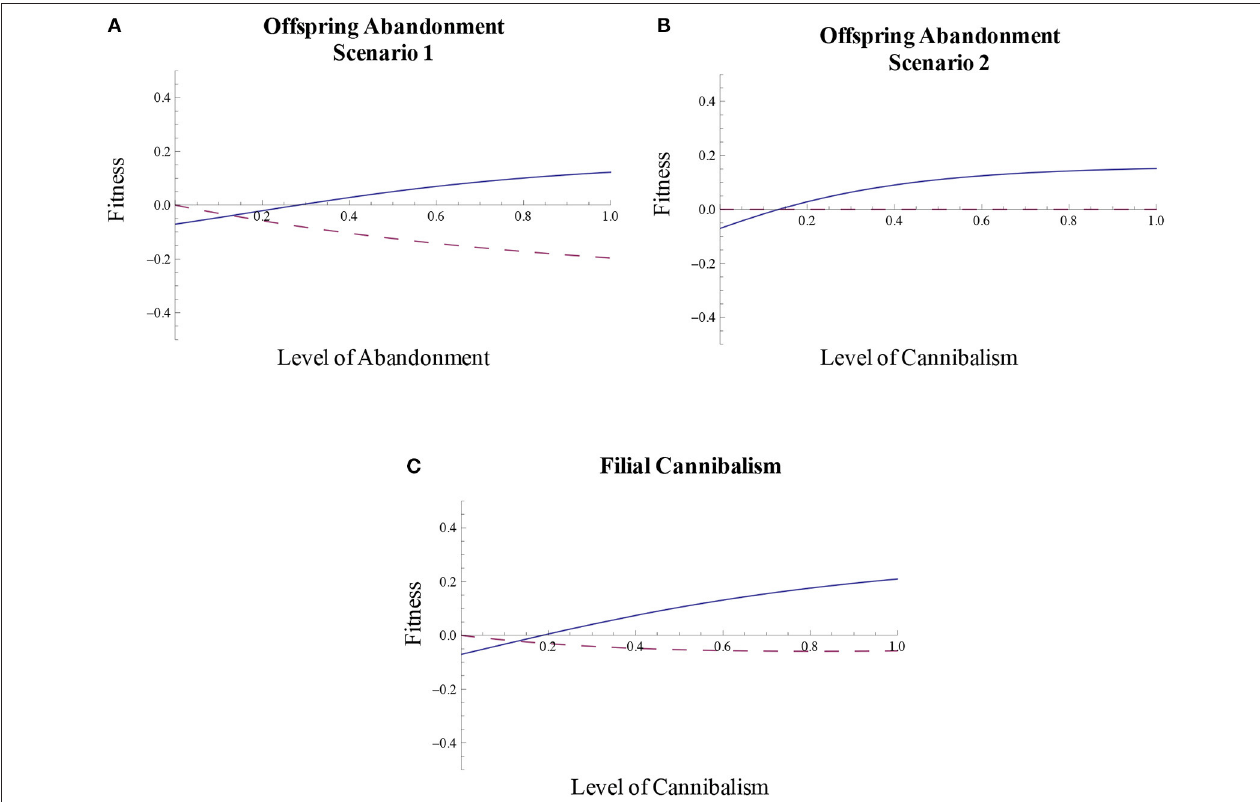
FIGURE 4 | Offspring abandonment and filial cannibalism function as forms of parental care . When (A) egg mortality increases as within-clutch density effects increase, offspring abandonment that initially decreases egg survival (abandonment scenario 1), beyond a threshold level, is associated with positive fitness and can function as a form of parental care in some cases (solid line). If egg mortality does not increase as within-clutch density effects increase, offspring abandonment will not function as a form of parental care (dashed line). When (B) egg mortality increases as within-clutch density effects increase, offspring abandonment that initially increases egg survival (abandonment scenario 2), beyond a threshold level, is associated with positive fitness and can function as a form of parental care in some cases (solid line). If egg mortality does not increase as within-clutch density effects increase, offspring abandonment will not function as a form of parental care (dashed line, which overlaps with the x-axis). When (C) filial cannibalism reduces the density effects on egg mortality and provides energetic benefits to parents, beyond a threshold, cannibalism can be associated with positive fitness and function as a form of parental care (solid line). If filial cannibalism does not reduce density